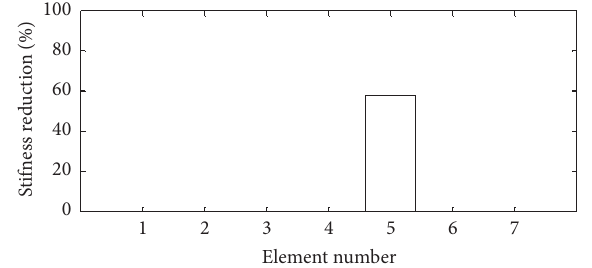
Figure 8: Assessment of experimental damage (55% stiffness reduc- tion in element 5).